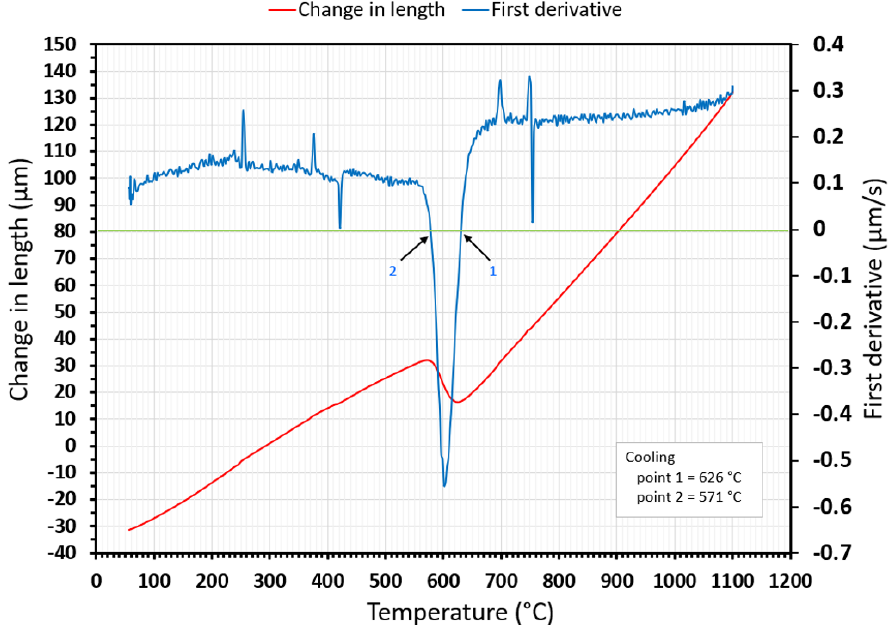
Figure 6. The cooling part of the dilatometry curve for a 1°C/s cooling rate with the first derivative applied. tive